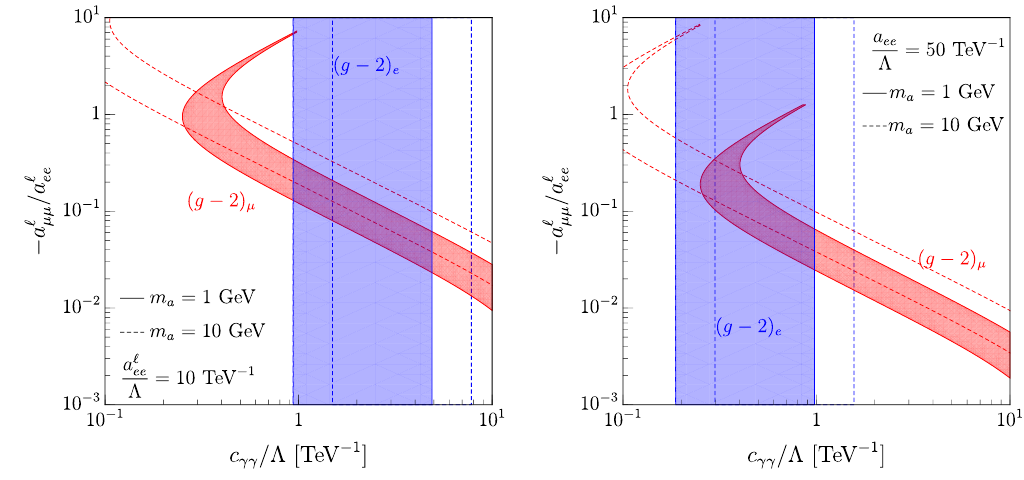
2) (cid:22) and ( g 2) e (cid:0) (cid:0)